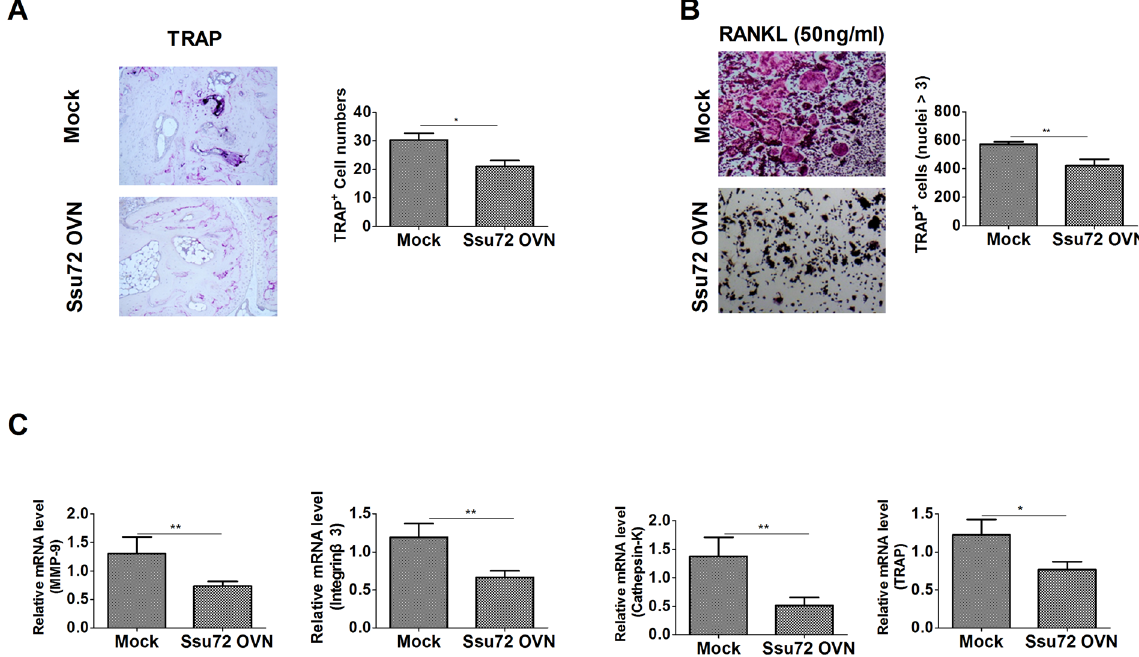
Figure 4. Ssu72 inhibits the progression of osteoclastogenesis. ( A ) TRAP expression in the synovium of mice with CIA (mock or Ssu72-overexpressing) was observed using immunohistochemical staining (original magnification, 200 × or 400 × , n = 6). ( B and C ) Bone marrow cells from mice with CIA (mock or Ssu72- overexpressing) were cultured with macrophage colony-stimulating factor (M-CSF) (10 ng/ml) and RANKL (50 ng/ml). Cells were fixed, stained for TRAP, and the number of TRAP + cells was counted using a light microscope (original magnification 100 × , n = 6). Real-time PCR was performed to measure the relative mRNA levels of osteoclastogenic markers (n = 6). The data represent the mean ± SD from three independent experiments. Statistical analyses were conducted using the nonparametric Mann-Whitney U -test ( * P < 0.05, ** P < 0.03, *** P <